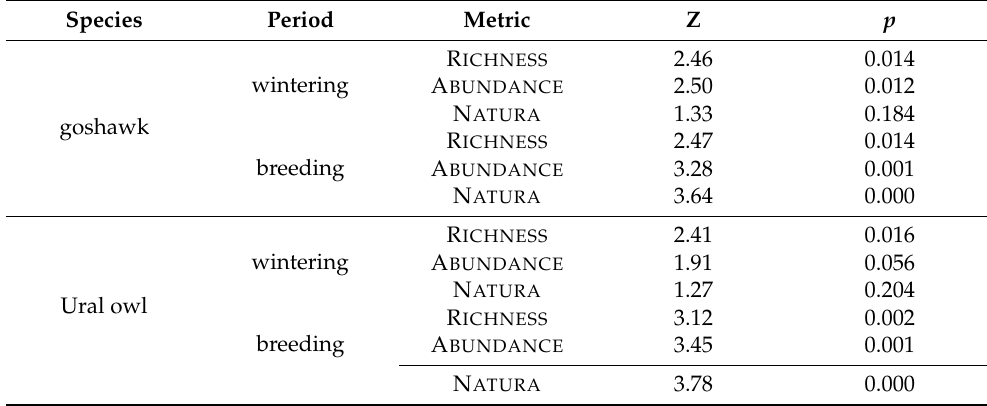
Table 1. Results of statistical comparison of bird diversity metrics between groups of plots (occupied vs control by goshawks or Ural owls, separately for two periods: winter and breeding). Species Period Metric Z p